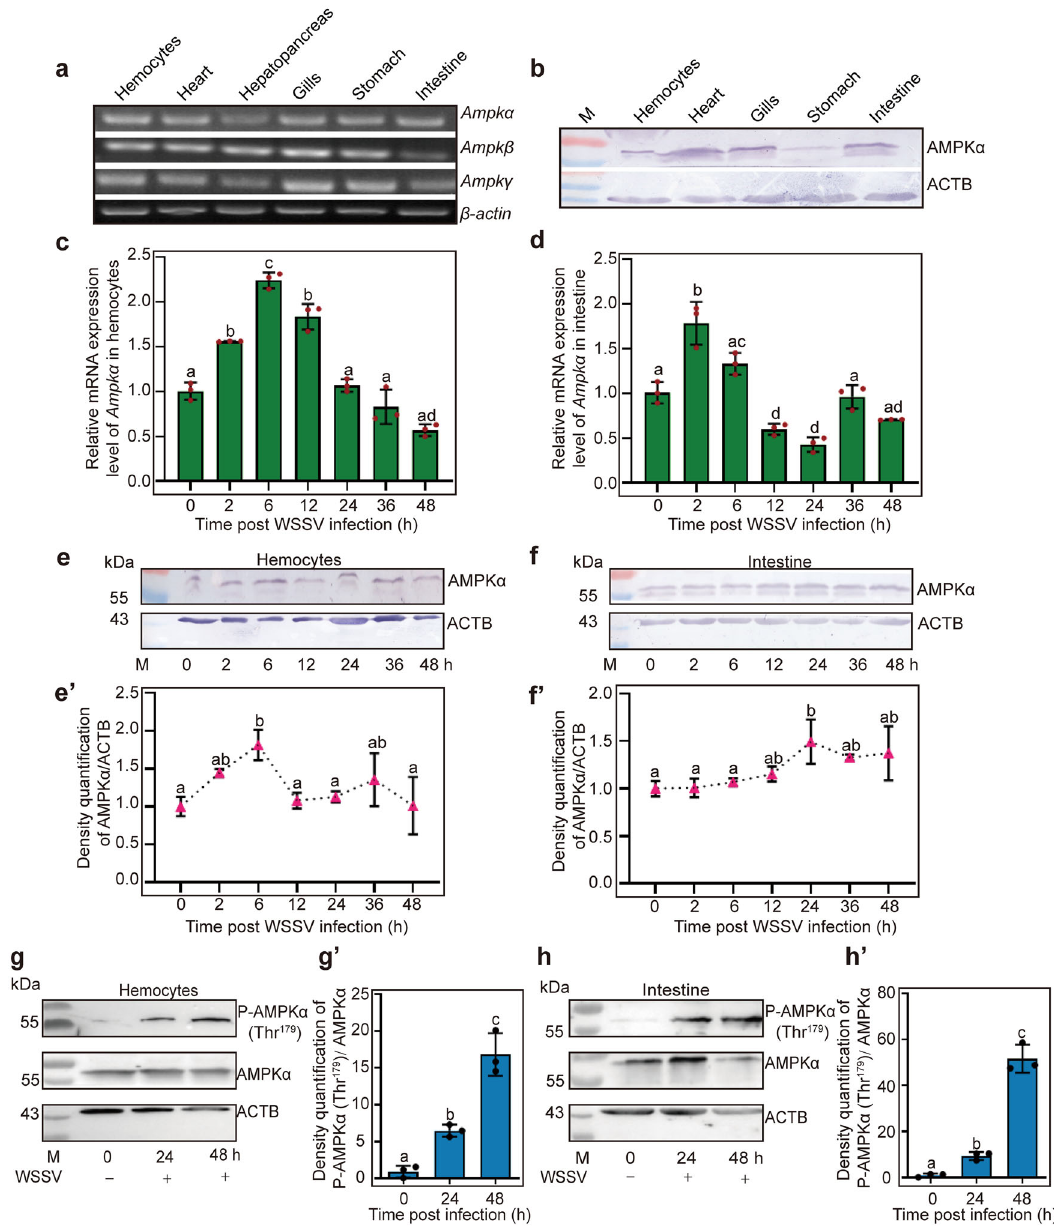
Fig. 1 AMPK expression and phosphorylation were upregulated in M. japonicas after WSSV challenge. a Tissue distribution of AMPK α / β / γ in M. japonicas at the mRNA level. b The distribution of AMPK α proteins in different tissues, detected using western blotting. c , d The expression patterns of Ampk α in hemocytes ( c ) and intestine ( d ) of shrimp challenged by WSSV, analyzed using qPCR. e , f Expression patterns of AMPK α at the protein level in hemocytes ( e ) and intestine ( f ) of shrimp challenged by WSSV, analyzed via western blotting. e ′ , f ′ is the statistical analysis of e , f based on three replicates. g , h AMPK phosphorylation in hemocytes ( g ) and intestine ( h ) were assayed in shrimp at 0, 24, and 48 h post WSSV infection using western blotting with an antibody recognizing phosphorylated AMPK; ACTB ( β -actin) was used as loading control. g ′ , h ′ is the statistical analysis of panel g , h based on three